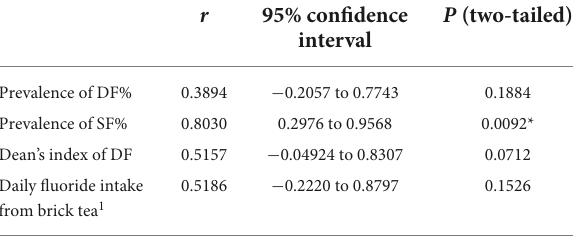
TABLE 6 Pearson correlation coefficients of DF- and SF-related variables with altitude. r 95% confidence P interval